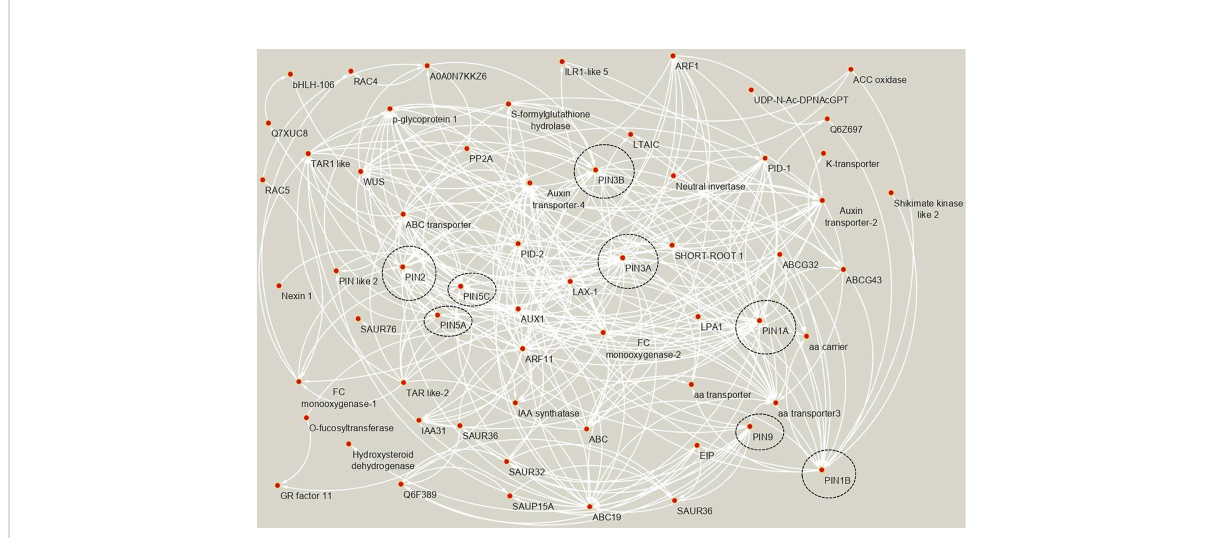
FIGURE 5 The co-expressed and interacting genes of rice PIN genes as evident by STRING analysis. Each arrow originates at the “ source node ” and ends at the “ target node. ” The “ source node ” corresponds to the “ effector protein, ” and the “ target node ” corresponds to the “ target protein. ” The nodes containing rice PIN proteins are encircled by black borders. All of the proteins mentioned in the network belong to Oryza sativa . The full name of the proteins, UniProt IDs, putative functions, and their classi fi cation into 12 categories are mentioned in Supplementary Table